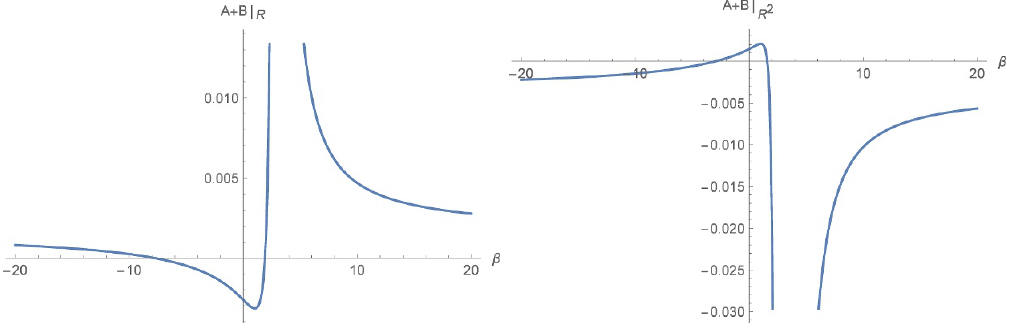
Figure 4 . (cid:12) -dependence of (4.4) (left) and (4.5)